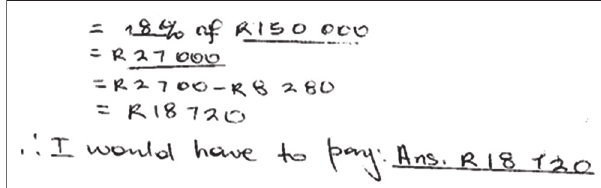
FIGURE 4: Response of KON 486 to Task 1.